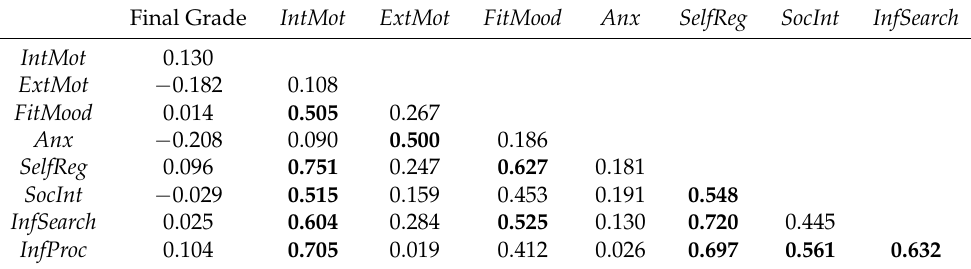
Table 8. Correlations table for SRLAS dimensions.